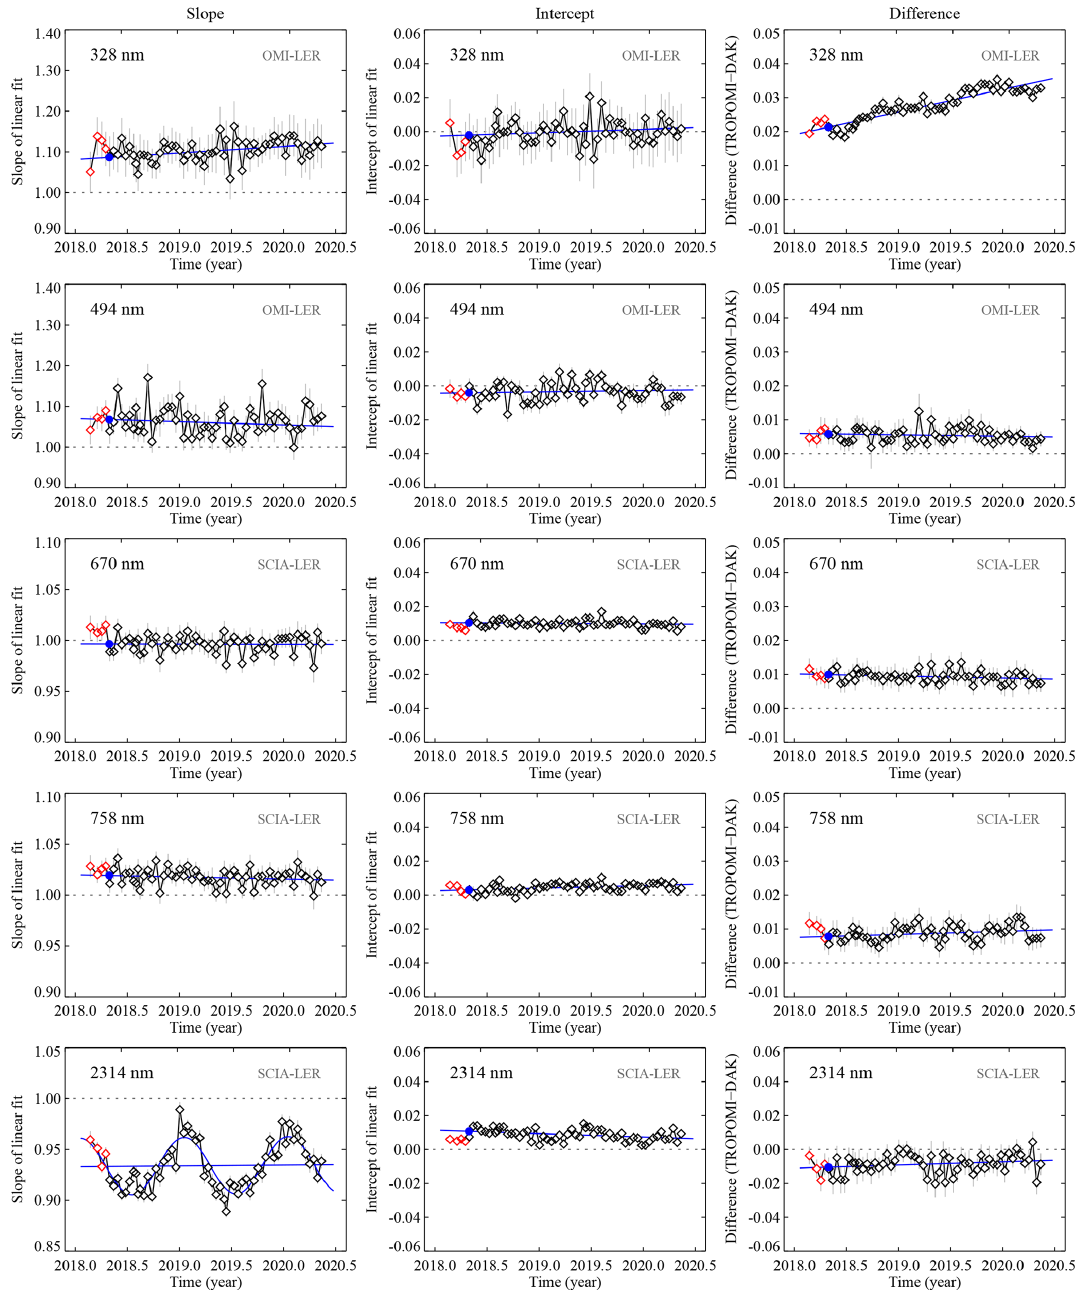
Figure 8. Time series of the slope m (left column) and intercept n (middle column) of the linear fit to the data in scatterplots such as shown in Fig. 7, for 5 of the 21 wavelength bands defined in this paper. The last column presents the mean differences d m between the TROPOMI and DAK reflectances. The red data points are based on data from the commissioning phase. These are plotted but not taken into account in the linear fits. In all cases the horizontal dotted line represents the situation of perfect agreement between measurement and simulation. The blue lines/curves are fits to the data and are discussed in Sect. 6.2. The blue circle illustrates the fit result for 30 April